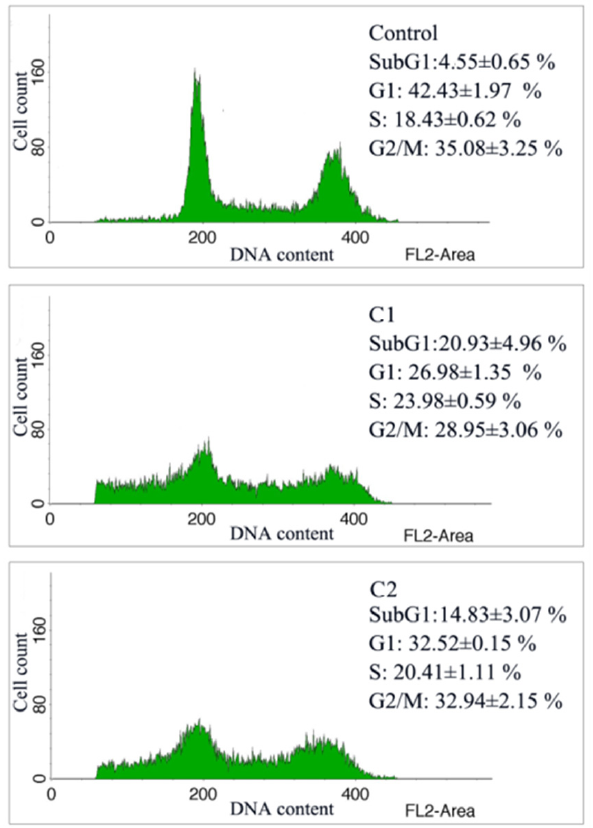
Figure 4. Cell cycle changes in phase distribution of HeLa cells induced by compound after 24 h of treatment.